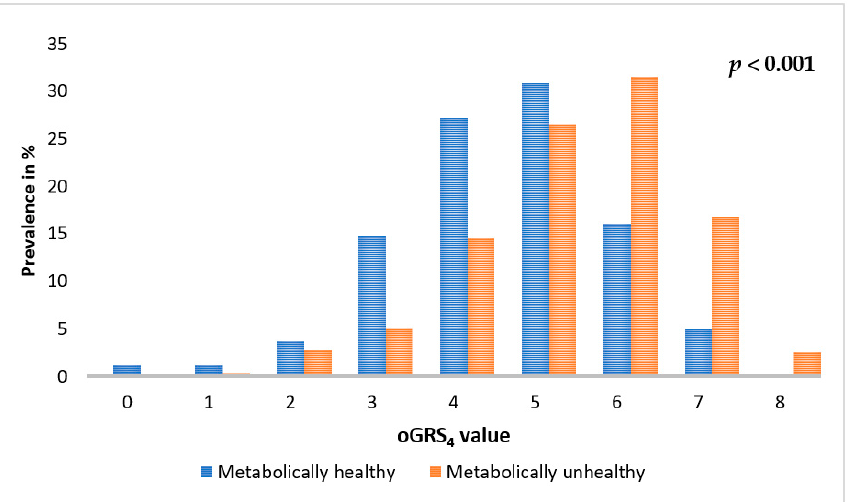
Figure 4. Comparison of the distribution of optimized genetic risk scores based on the four most strongly associated SNPs in metabolically healthy and unhealthy obese individuals. strongly associated SNPs in metabolically healthy and unhealthy obese